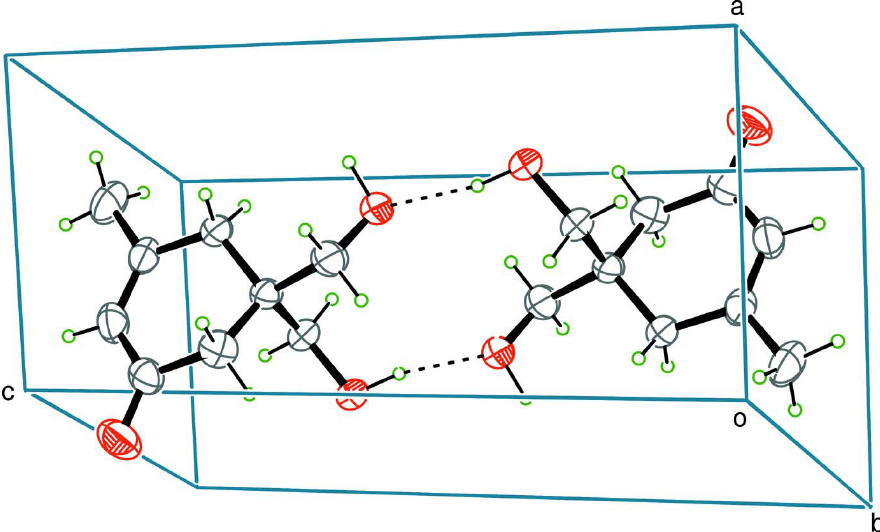
Figure 2 A partial packing diagram viewed along the b axis. Hydrogen bonds are drawn as dashed